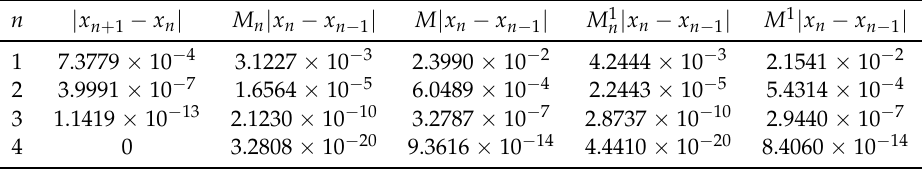
Table 2. Results for ε = 10 − 15